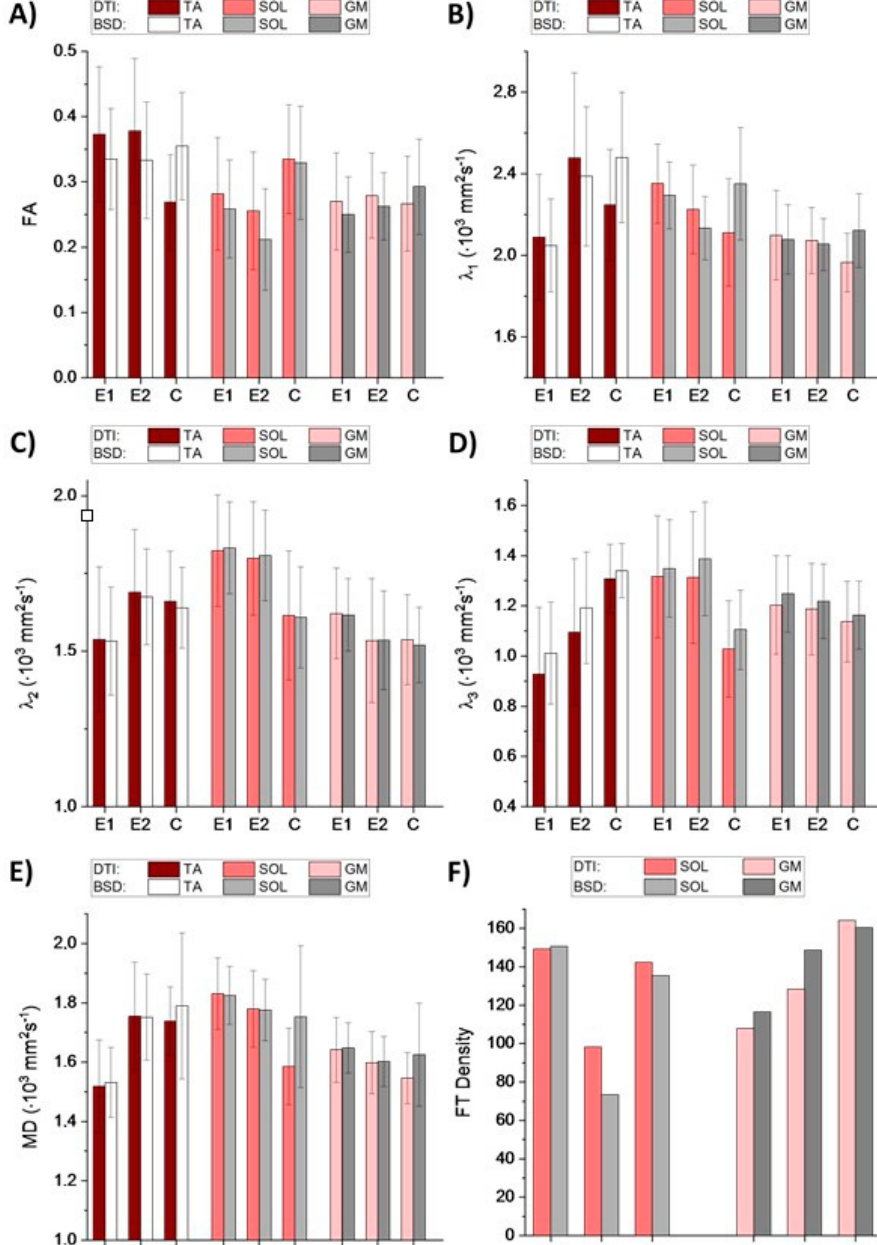
Figure 1. Diffusion tensor parameters: fractional anisotropy (FA) ( A ), λ 1 ( B ), λ 2 ( C ), λ 3 ( D ), mean diffusivity (MD) ( E ) and fiber tracts (FT) density ( F ) obtained for the patient before (E1) and after (E2) the intervention and the control (C) with and without the calibration of a gradient field using the B-matrix spatial distribution (BSD) method.